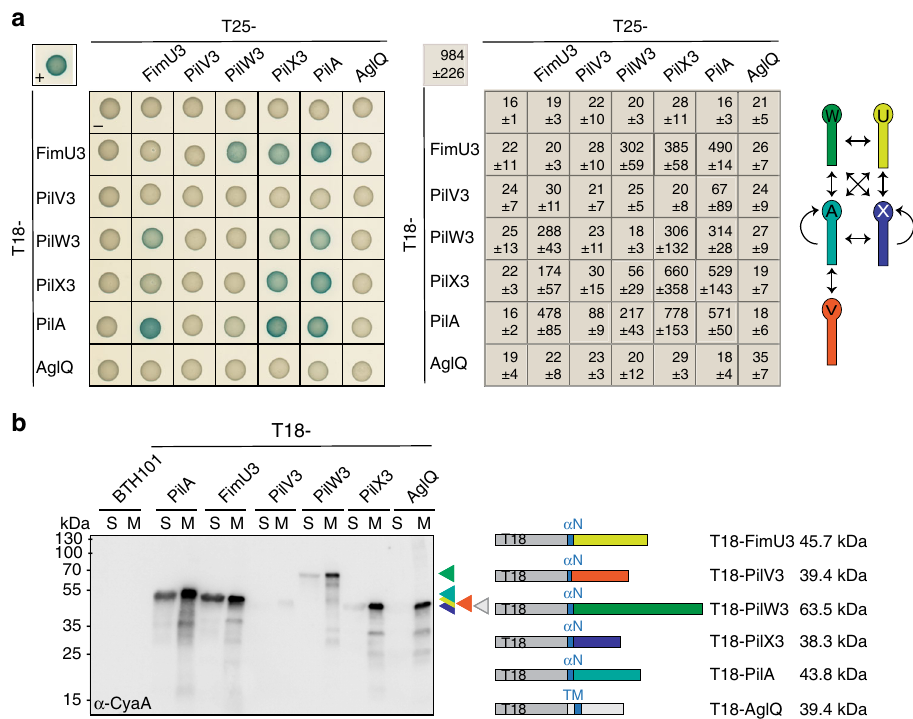
Fig. 2 PilA and cluster_3 minor pilins interact. a BACTH analysis of PilA and cluster_3 minor pilin interactions. T25 and T18 were fused to the N-terminus of the indicated mature, full-length proteins. Positive control (plus) in upper left corner, T25-Zip + T18-Zip; T18 and T25, negative control (minus). Full- length AglQ fused to T25 and T18 served as a speci fi city control. Left panel, representative images of E. coli BTH101 expressing the indicated protein fusions. For every tested interaction pair, four clones were tested with similar results. Middle panel, relative activity of β -galactosidase shown as mean ± standard deviation ( n = 4) for the pairs on the left. Right panel, schematic summarizing observed interactions. b Fractionation of BTH101 E. coli cells expressing the indicated T18 fusions. Cleared cell lysates were fractionated into soluble (S) and membrane (M) fractions. α N N-terminal α -helix in mature pilins, TM trans-membrane helix in AglQ. Proteins from the same number of cells were loaded per lane. Right panel, schematics of domain organization and calculated molecular sizes of the corresponding